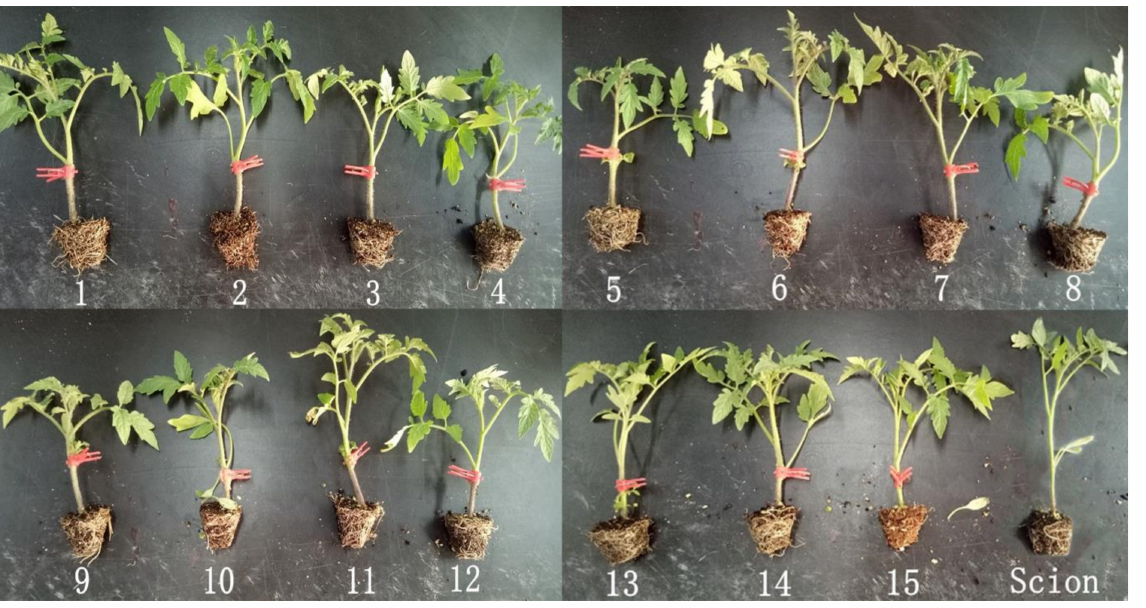
Figure 1. Growth of tomato seedlings grafted onto 15 rootstock genotypes at 20 days after grafting. 1–15 represent the grafted tomato seedlings with the 15 rootstock genotypes, respectively, and the nongrafted scion “Mingzhi88” was used as a